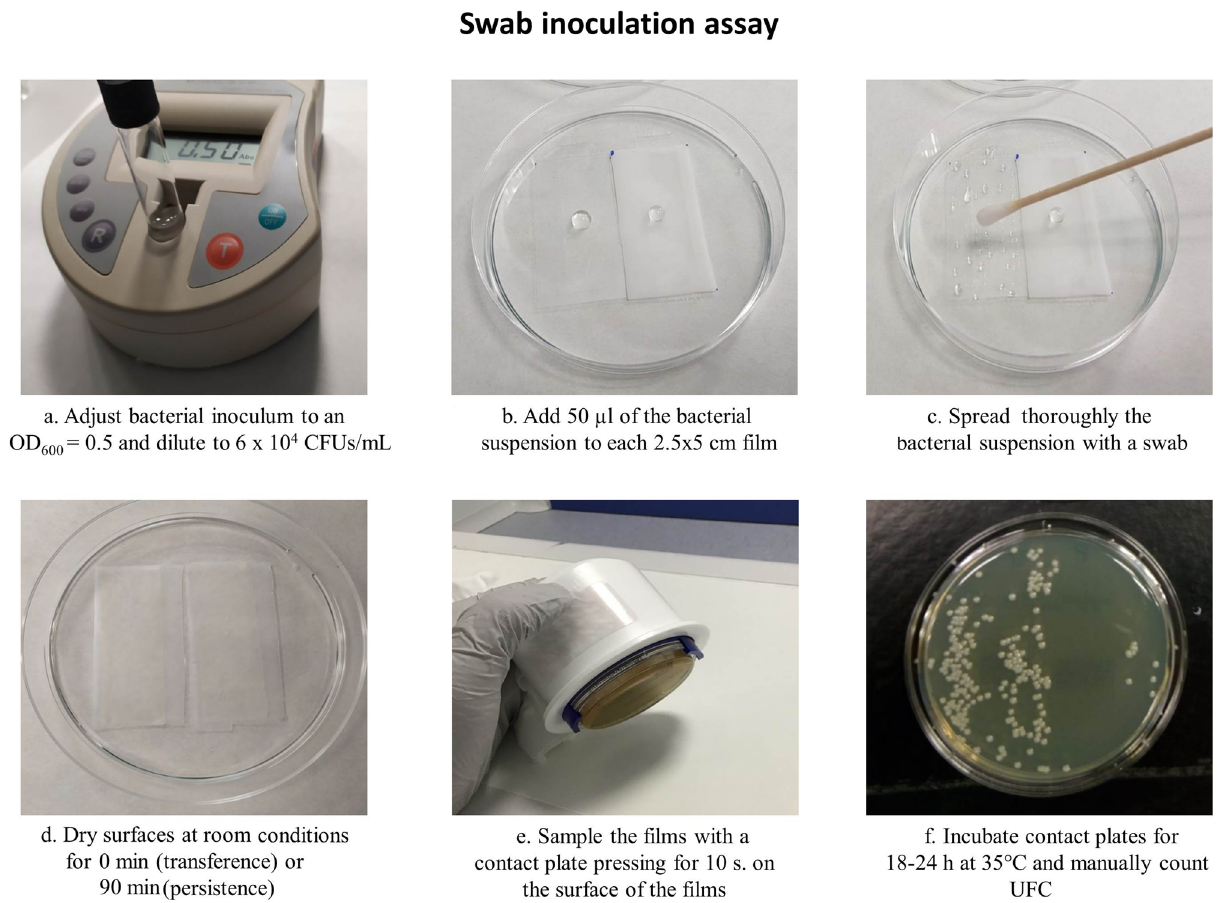
Figure 4. Schematic representation of the swab